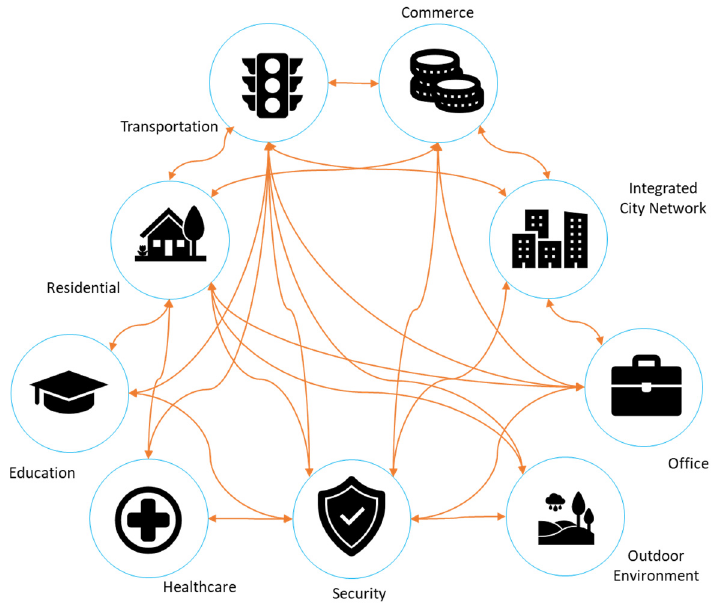
Figure 1. The concept of U-city and interconnectivity of service areas.